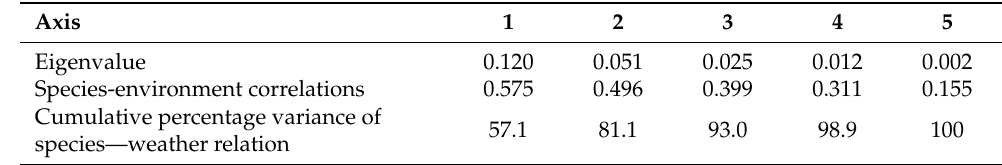
Table 3. Results of ordination of the canonical correspondence analysis accounted for the first five axes. Axis